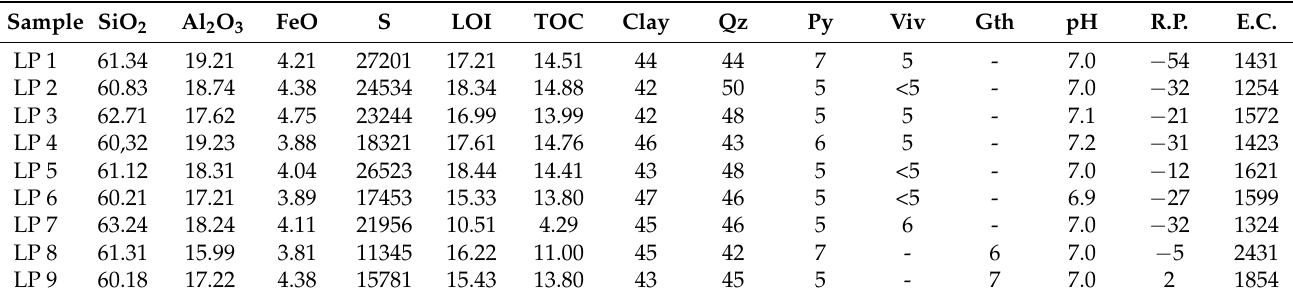
Table 1. Sediment characterization of La Playa sediments. Major element sediment compositions of the untreated samples determined by XRF (X-ray fluorescence spectroscopy), loss of ignition (LOI), content in total organic carbon (TOC) and mineral abundances determined by XRD (in weight percentage, except for S in mg/kg). In situ physicochemical properties. R.P.: redox potential (mV); E.C.: electrical conductivity ( µ S/cm); Qz: quartz; Py: pyrite; Viv: vivianite; Gth: